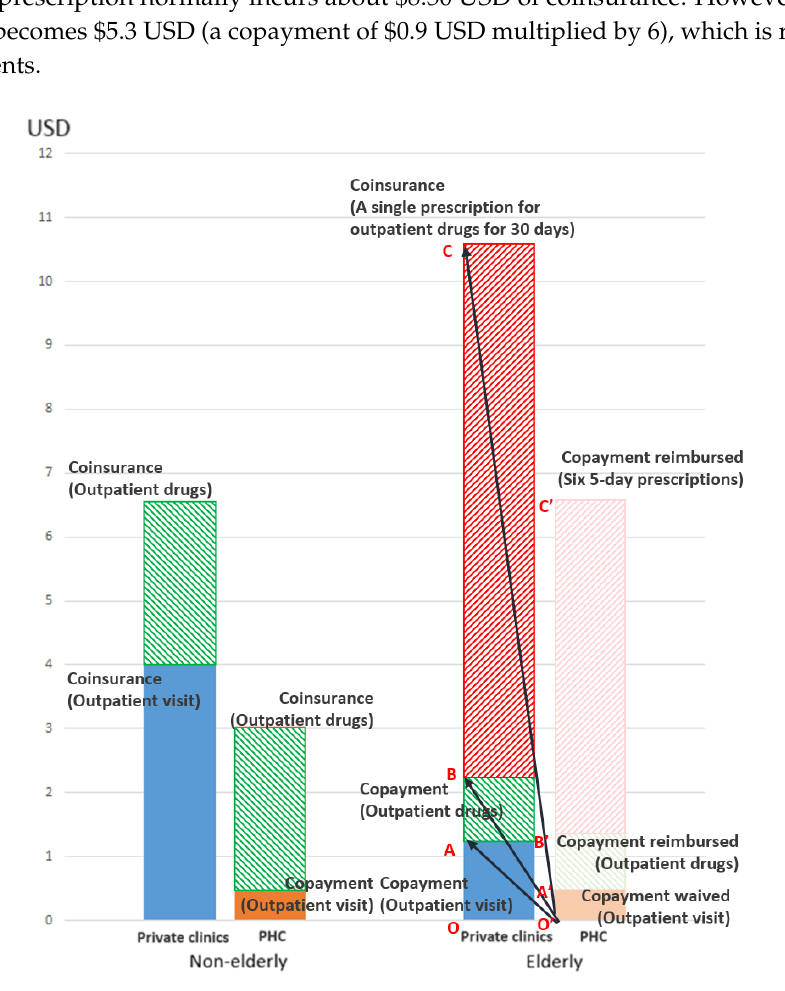
Figure A2. Out-of-pocket expense for an outpatient visit and outpatient drugs in the public health clinics and private clinics. This estimate is when the total cost (OOP + NHI reimbursement) is assumed